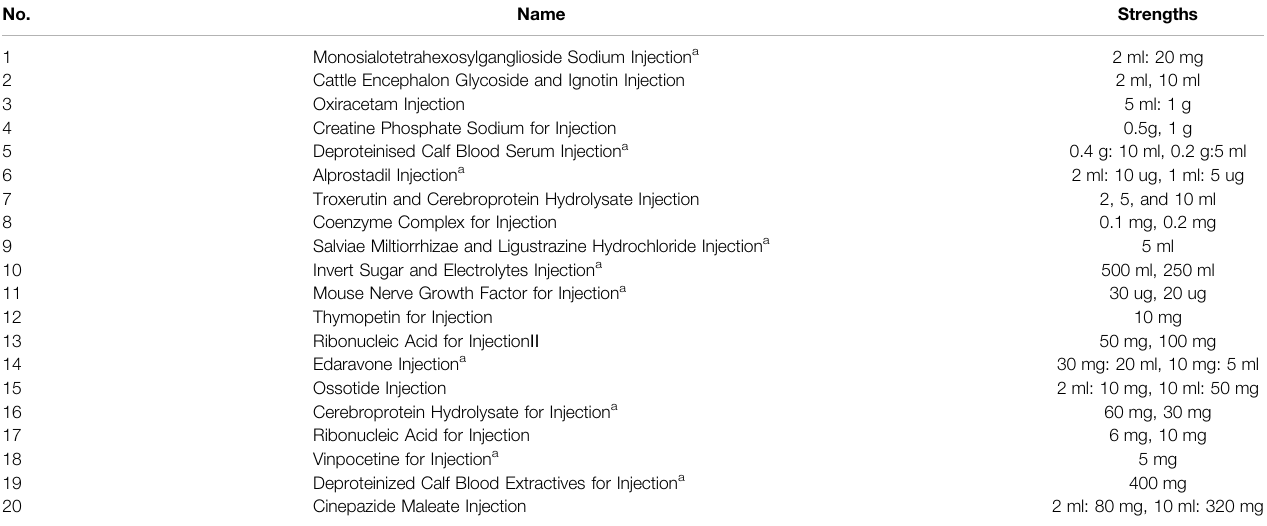
TABLE 1 | The catalogue of National Key Monitoring